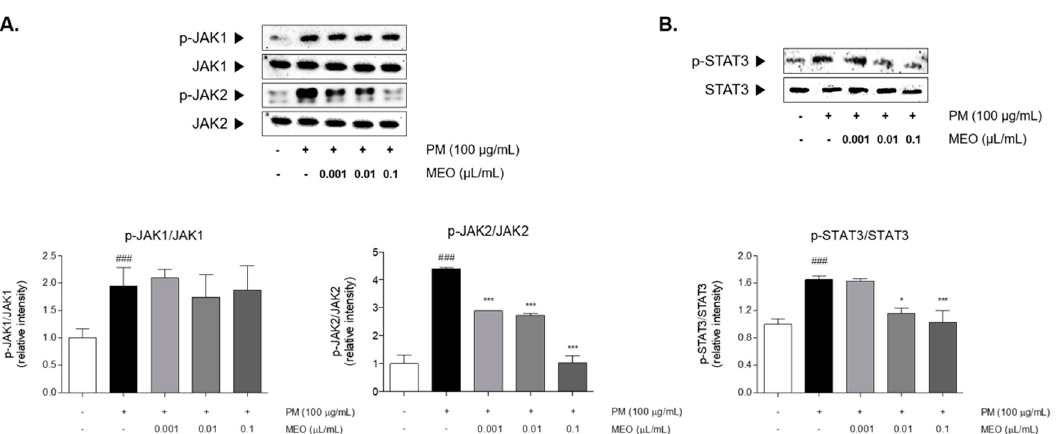
Figure 5. The protein expressions of JAK1 and JAK2 in PM 10 -exposed A549 lung epithelial cells ( A ). The protein expression of STAT3 in PM 10 -exposed A549 lung epithelial cells ( B ). The experiments were carried out in triplicate measurements. Results are presented as mean ± standard error of the mean. ### p < 0.001 vs. non-treated cells; * p < 0.05, ** p < 0.01 and *** p < 0.001 vs. PM 10 -treated cells.